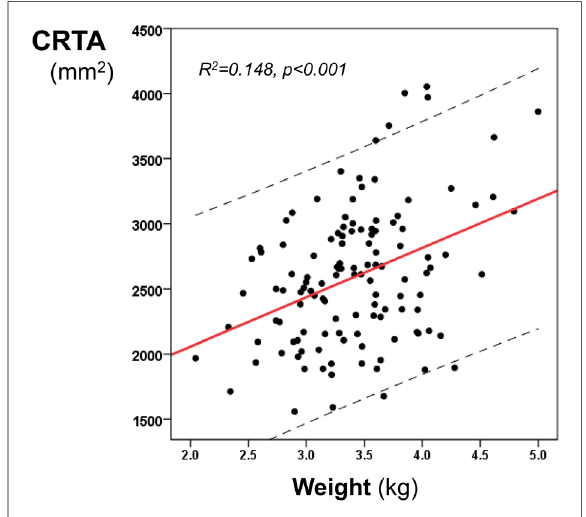
FIGURE 2 Linear regression analysis of the CRTA and the birth weight. The regression line and 95% con fi dence intervals (dashed lines) are